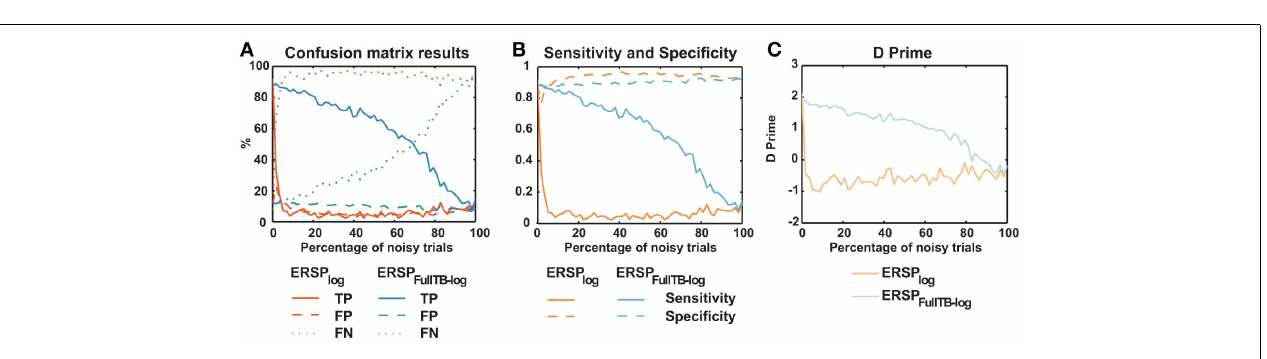
(ERSP FullTB − log ) clearly outperforms the classical method (ERSP log ). (B) Sensitivity and specificity of the two methods. (C) d (cid:2) results for the two methods. Significance of ERSP results is computed using baseline permutation statistical